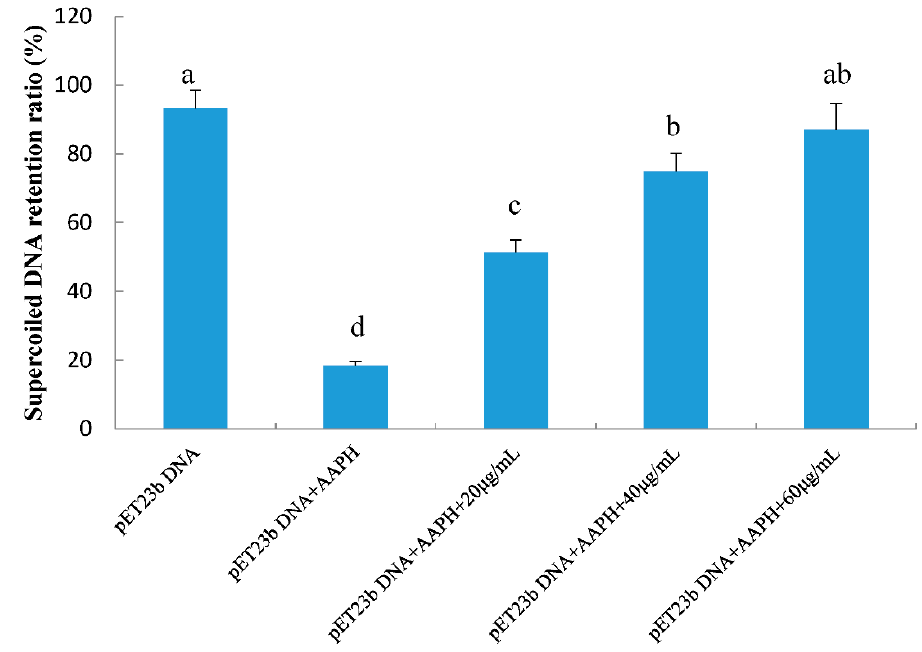
Figure 5. Effects of RPP with different concentrations on supercoiled DNA retention in AAPH-induced DNA damage in vitro systems. Groups with different letters are significantly different ( p < 0.05).